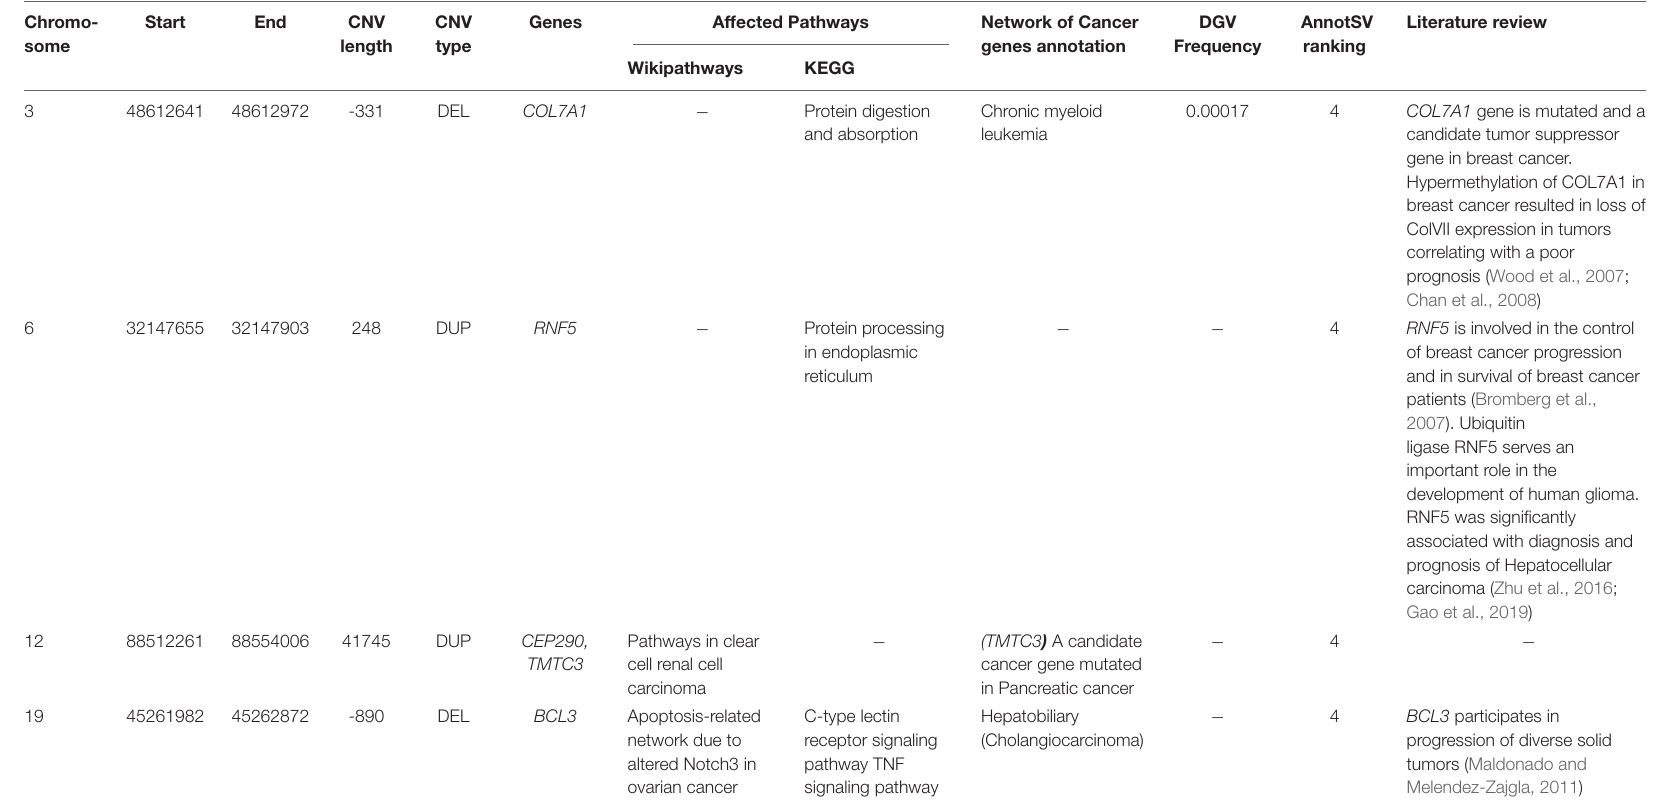
AnnotSV ranking: 4 Likely